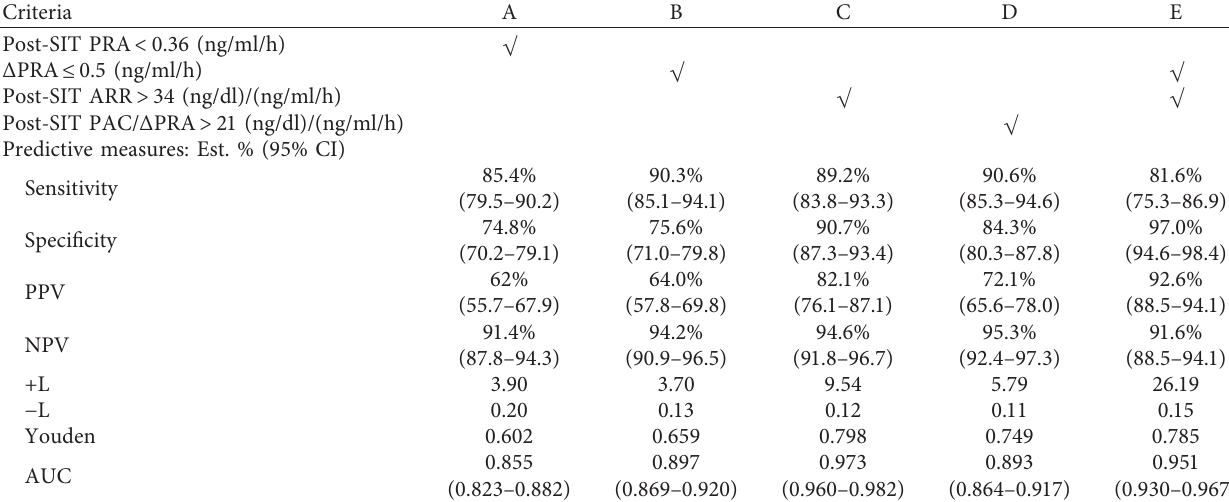
Table 2: Diagnostic values for combined criteria using various combinations of SIT parameters.